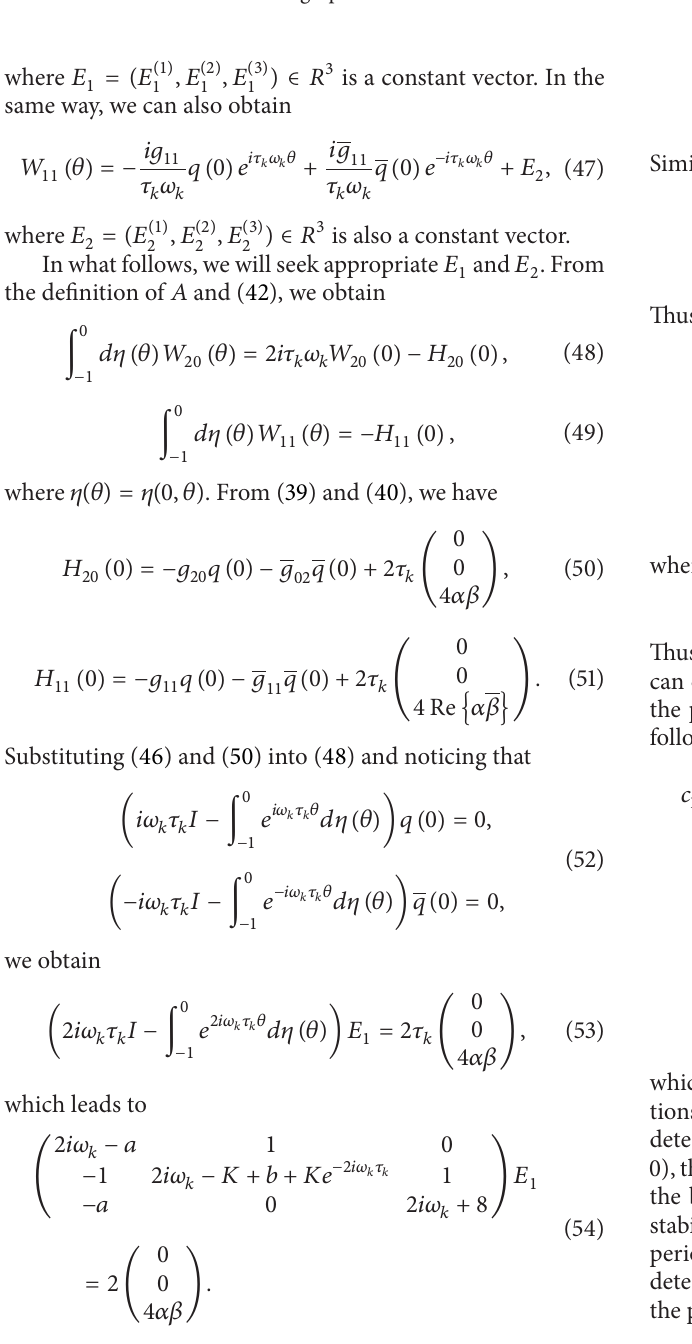
Figure 2: The bifurcation graph with 𝜏 when 𝐾 = −1